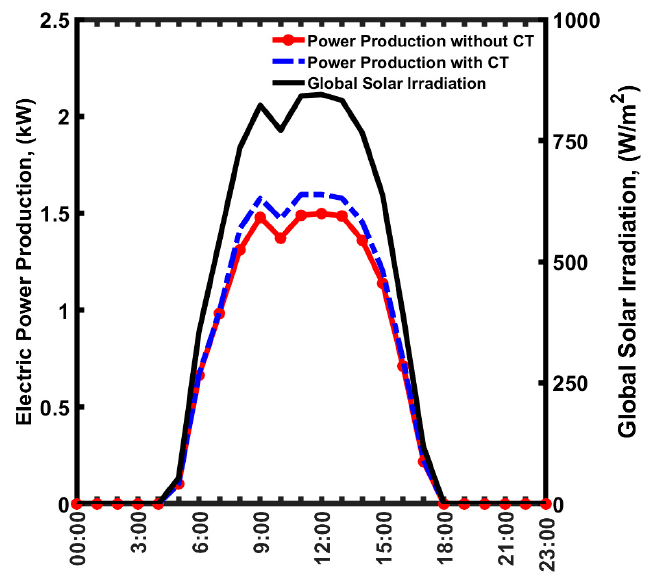
Figure 6. 24-hour profile of the PV panels power production with and without the CT on 21